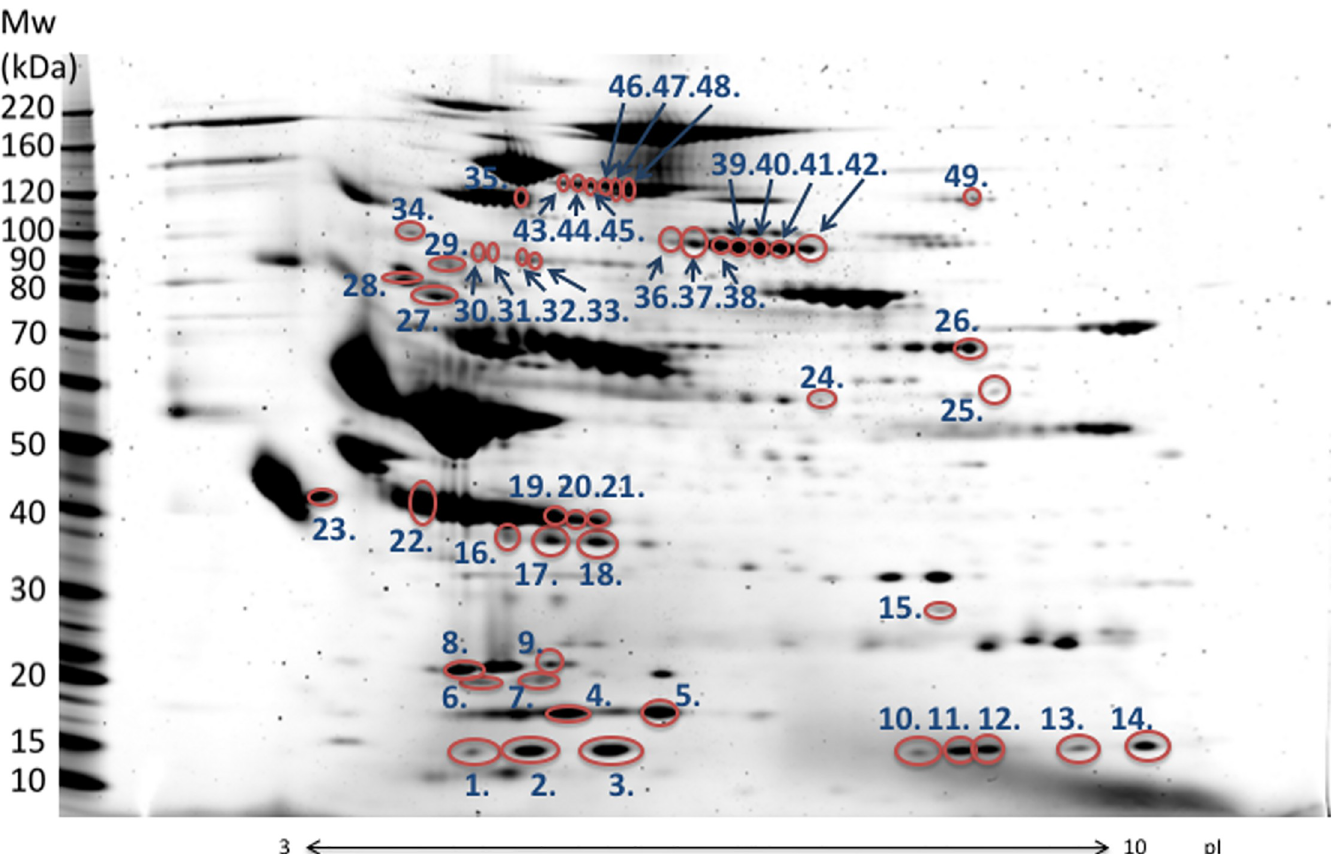
Fig 2. Two-dimensional electrophoresis image of patient serum. Serum from sample no. 9 (A, start of the treatment) was used. Molecular weight is indicated on the vertical axis, and isoelectric point is indicated on the horizontal axis. Among spots which signal changed substantially over time, those that were successfully identified are circled in red and